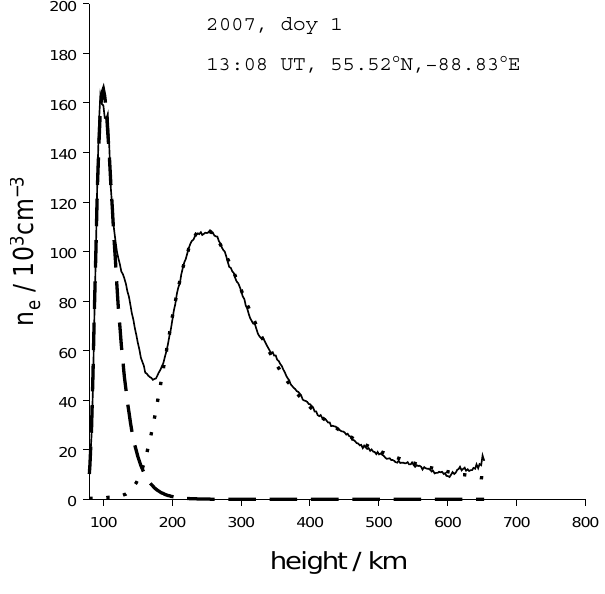
Fig. 1. Shown is a Formosat-3/COSMIC profile (solid line) with E-layer dominating ionosphere and the E-layer (dashed) and F- layer/topside (dotted) functions resulting from the fit explained in Sect. 2.